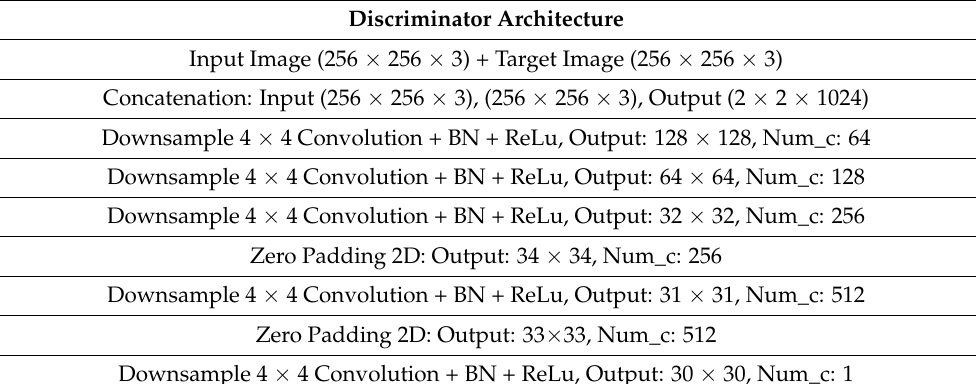
Table 2. Discriminator architecture of the CGANet